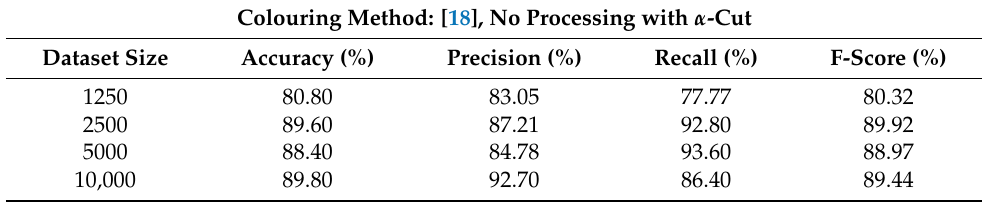
Table 4. Performance metrics for [18], without α -cut processing.